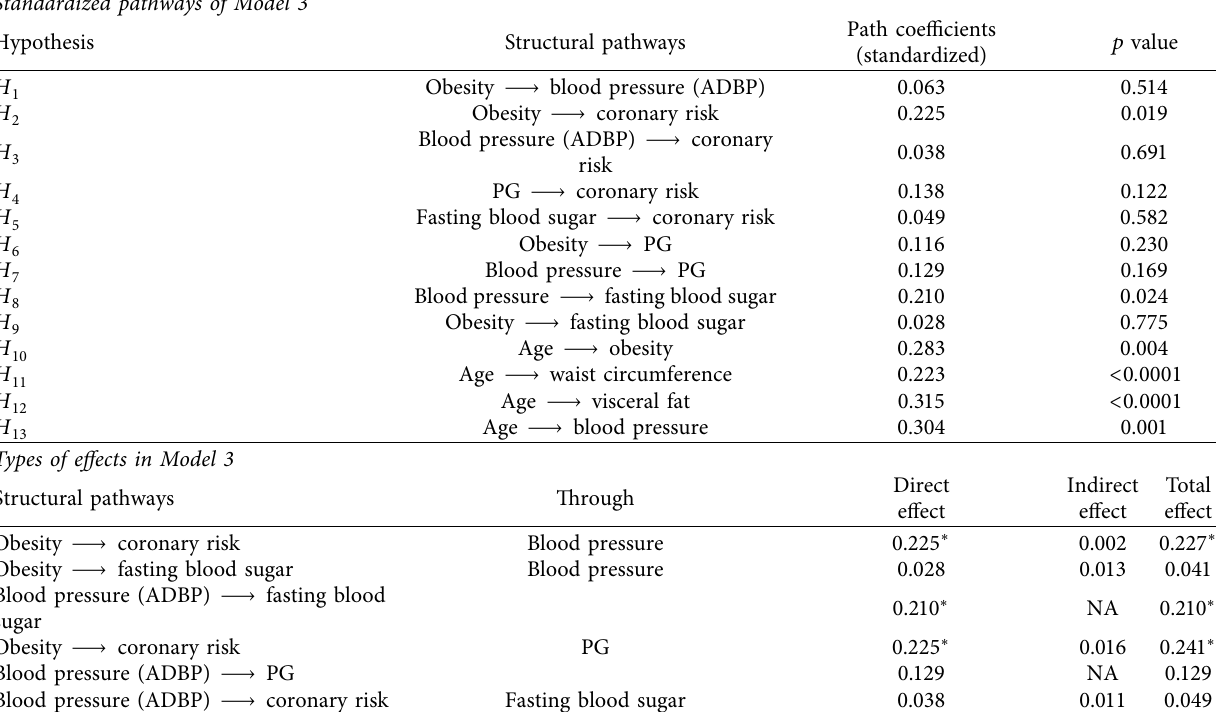
Table 6: Standardized pathways and type of effects of Model